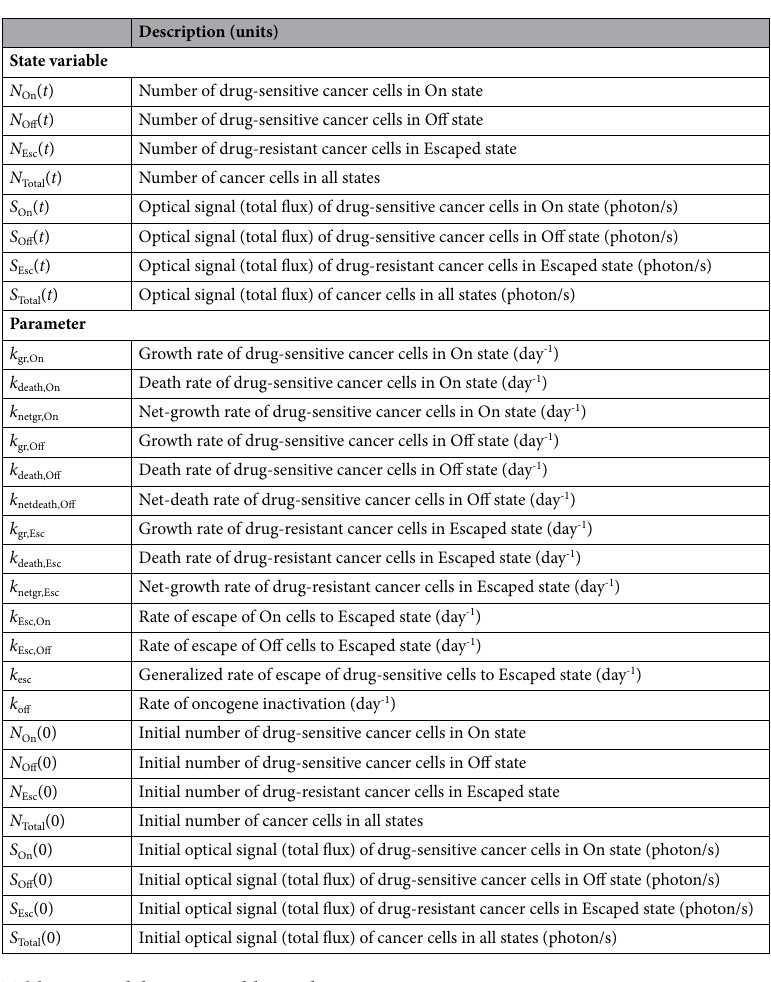
Table 1. Model state variables and